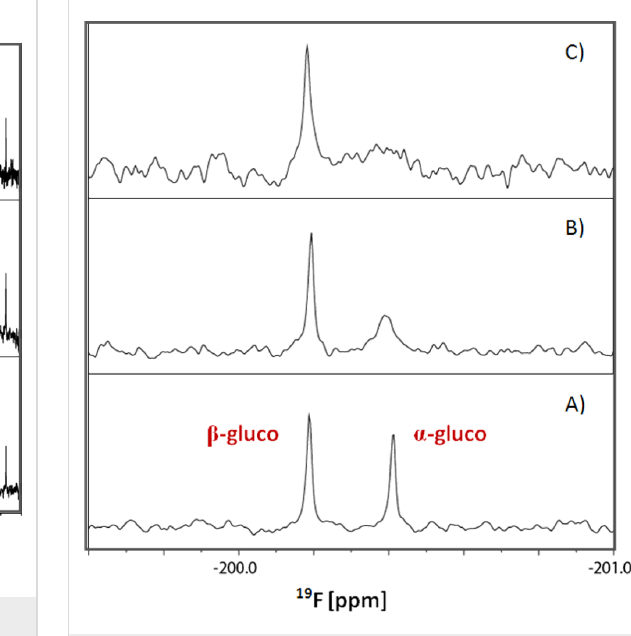
Figure 4: 19 F NMR expansion (of Figure 3) of the gluco-type region of the 2-F-maltose reporter system. performed with maltose, maltotriose, maltohexose